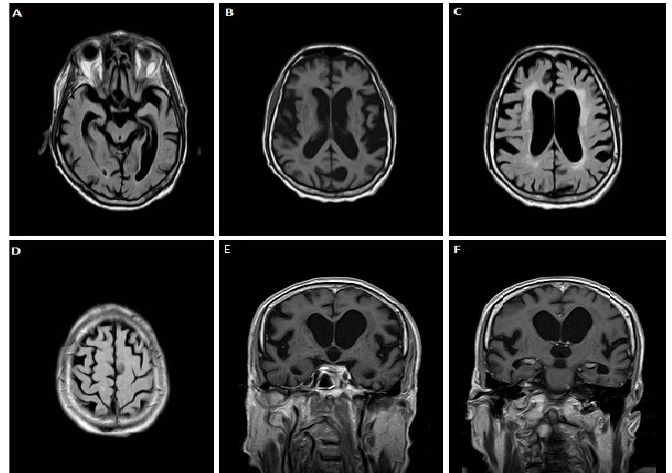
Figure 3. Brain MRI of case 3. FLAIR images ( A , C , D ) show severe cortical atrophy in frontal and temporal lobes. In axial ( B ) and coronal T1 section ( E , F ) atrophy of the perisylvian and parietal areas is also evident.